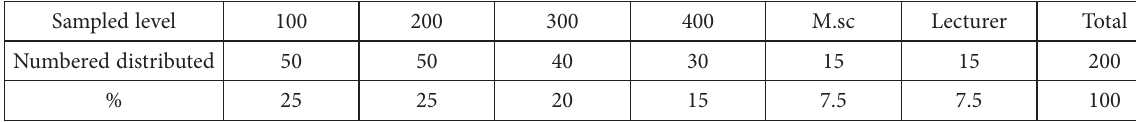
Table 1. Distribution of level of study respondent